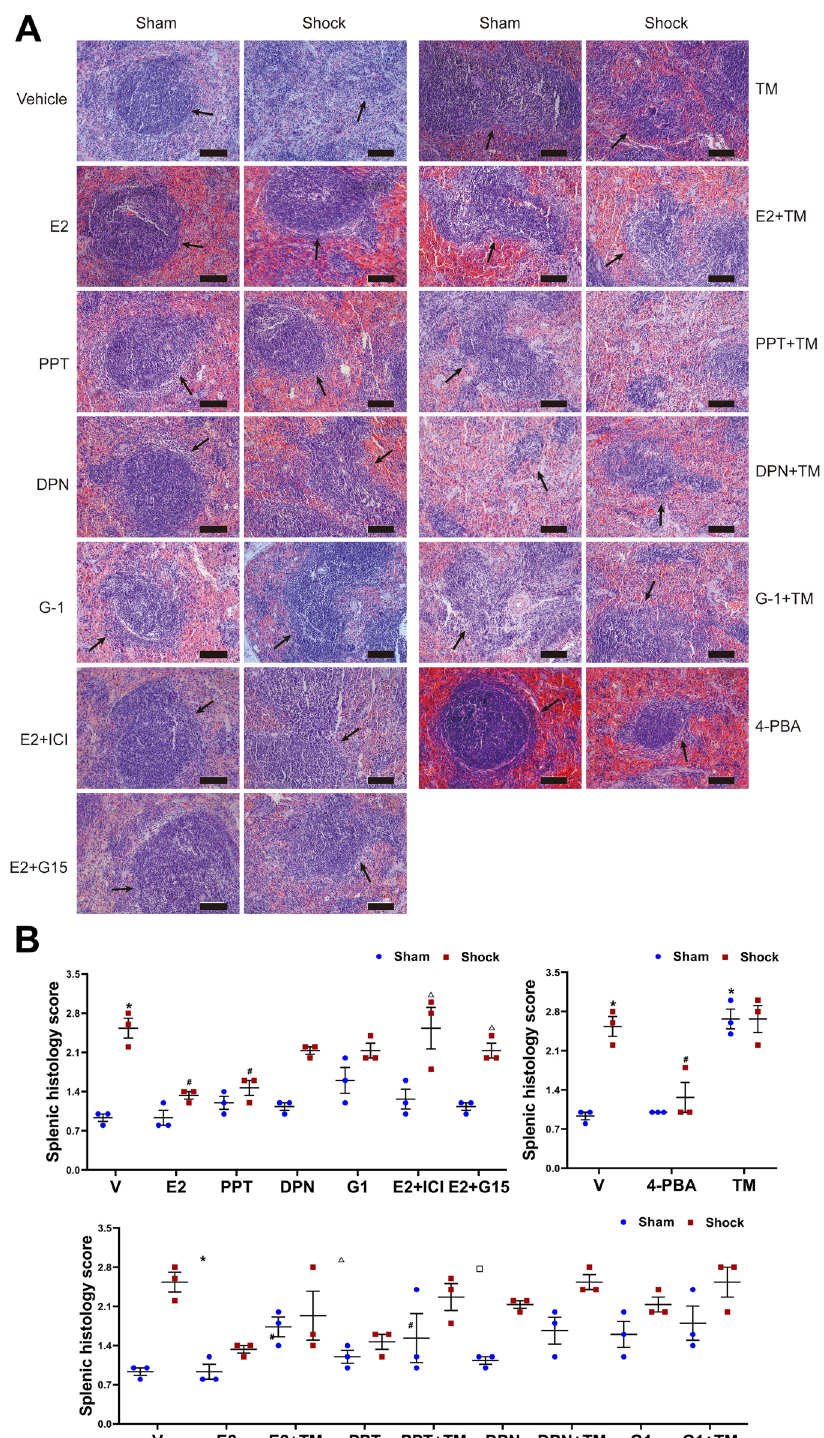
Figure 3. Histological examination of spleen in rats following hemorrhagic shock. The animals were sacrificed at 3 h after resuscitation or each time and treated with vehicle, 17-estradiol (E2), propyl pyrazole triol (PPT), diarylpropionitrile (DPN), G-1, E2 and ICI 182,780 (E2 + ICI), E2 + G15, 4-Phenylbutyric acid (4-PBA), tunicamycin (TM), E2 + TM, PPT + TM, DPN + TM, G-1 + TM, respectively. ( A ) Representative sections of hematoxylin and eosin staining for three animals per group viewed under 20 × objective lens. Arrows indicates the structural change of splenic white pulp from the red pulp regions for the evaluation of splenic structural injury. Scale bar: 100 μm. ( B ) Splenic histology score. Data are mean ± SE of 3 animals in each group. *p < 0.05 vs. the sham + vehicle group, #p < 0.05 vs. the shock + vehicle group, △ p < 0.05 vs. the shock + E2 group, □ p < 0.05 vs. the shock + PPT